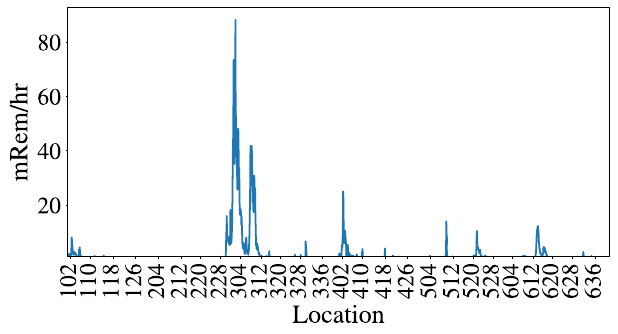
FIG. 13. A DALE survey showing dose rates at locations around the tunnel. Readings are normalized to 1 hour after